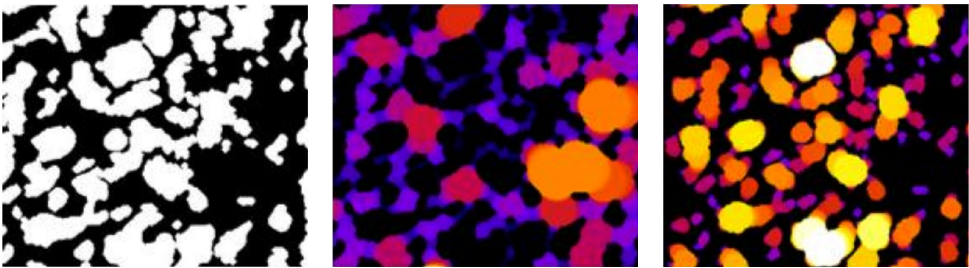
Figure 4. 2D imaging approximation for porosity assessment: ( left ) binary image of a face of one bone cube sample, ( center ) Tb.Th color map which contains circles that were found in the area that represents bone, and ( right ) Tb.Sp color map showing circles that represent